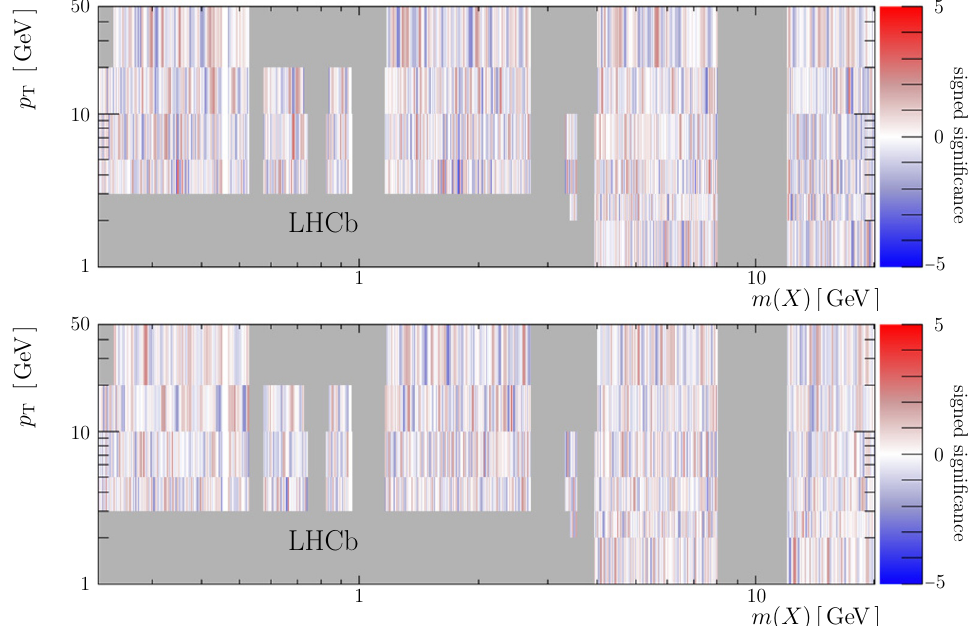
Figure 3 . Signed local signi(cid:12)cances in the m ( X ) < 20 GeV region for the (top) inclusive and (bottom) associated beauty searches for prompt X (cid:22) + (cid:22) (cid:0) decays. If the best-(cid:12)t signal-yield ! estimator is negative, the signed signi(cid:12)cance is negative and vice versa . The grey regions are excluded either due to a nearby large QCD resonance contribution, or because the overlap of the bin with the (cid:12)ducial region in table 1 is